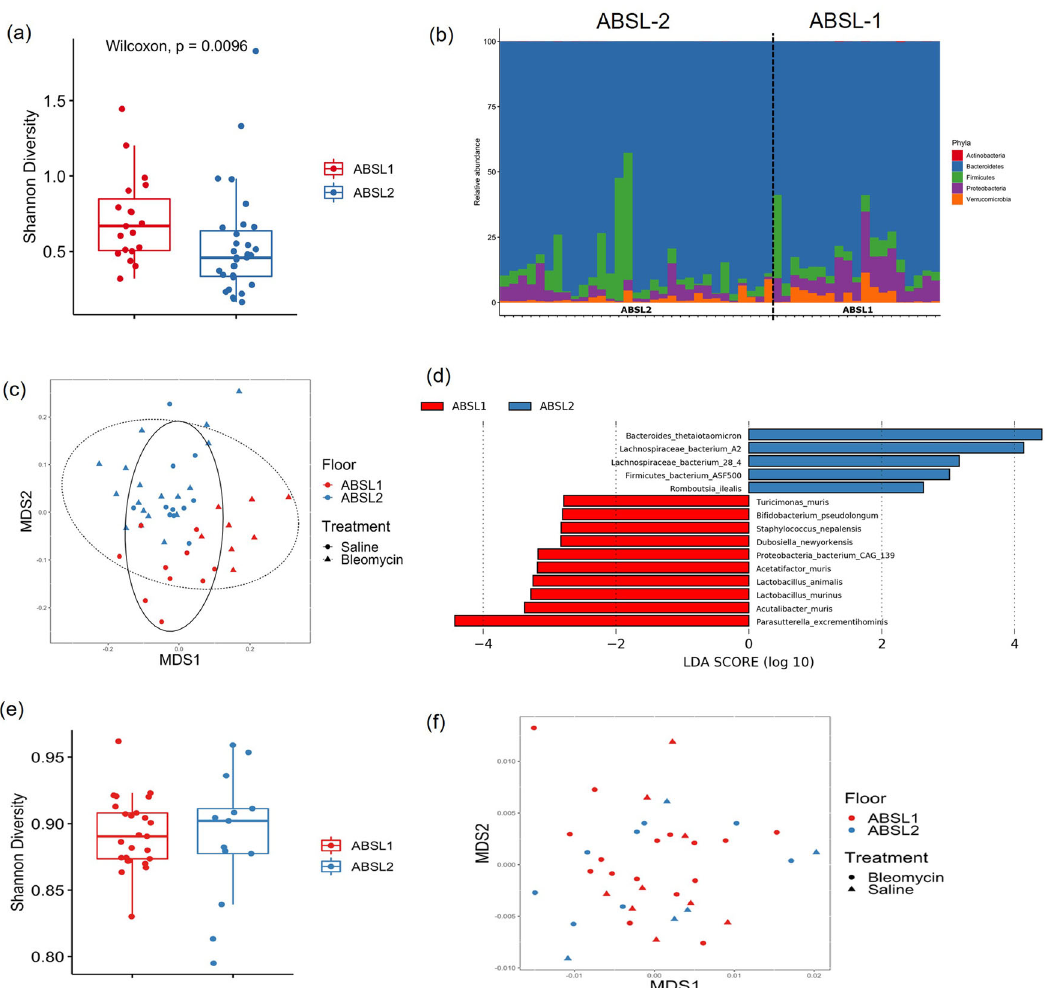
Fig. 2 Increased gut microbial diversity is associated with better outcomes in murine model of fi brosis. a Shannon diversity index scores for mice housed in ABSL-1 and ABSL-2 facilities and intranasally inoculated with 75 μ l containing 0.04 Units of bleomycin or saline (saline) ( n = 13-27 mice per cohort). The boxes show the median, as well as the 25 th and 75 th quartiles. The whiskers extend to 1.5*IQR. Each dox represents one mouse. b Phyla-level composition of the gut microbiome of ABSL-1 and ABSL-2 mice. c Nonlinear multidimensional scaling (MDS) plot showing differences in microbial taxonomic composition based on Jaccard dissimilarities. d Results of linear discriminant analysis showing taxa that are overrepresented in ABSL-1 or ABSL- 2 mice. e Within-sample diversity for lung microbiome samples from mice housed on ABSL1 and ABSL2 fl oors. f Nonmetric multidimensional scaling plot based on Bray-Curtis dissimilarities showing the lung microbiome communities of mice housed on ABSL1 and ABSL2 fl oors. The experiment was independently conducted